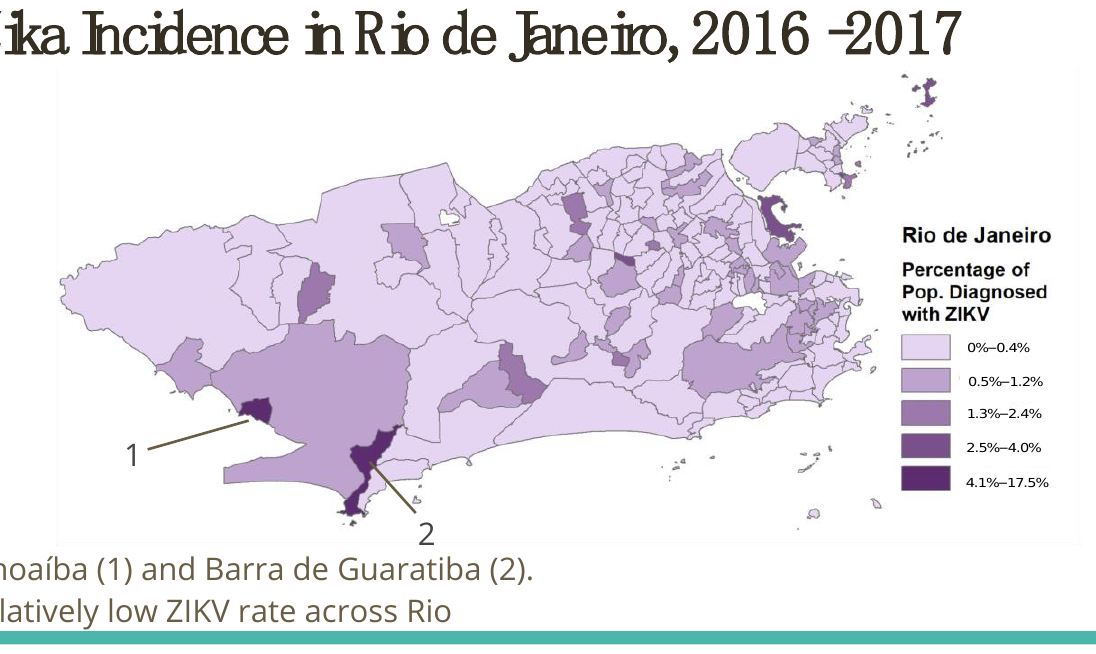
Figure 3. Zika Incidence in Rio de Janeiro, 2016–2017.